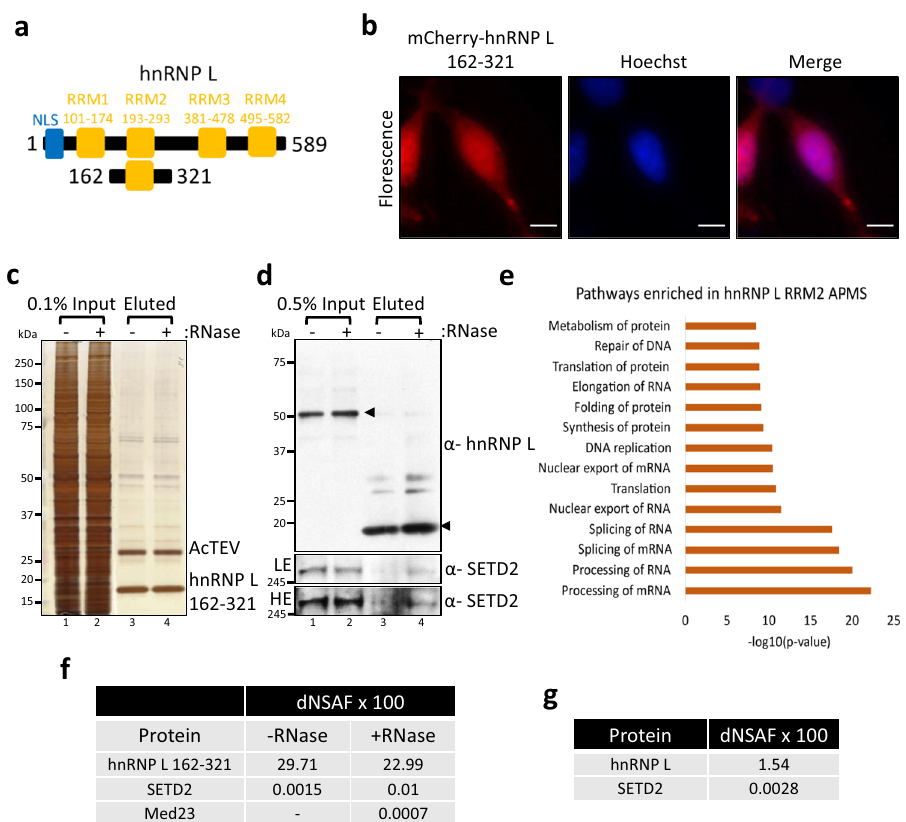
Fig. 1 Puri fi cation of hnRNP L RRM2 reveals SETD2 as an interactor. a Cartoon illustrating the truncation of hnRNP L along with the known domains. RRM RNA-recognition motif, NLS nuclear localization signal. b Microscopy images showing localization of mCherry-hnRNP L 162 – 321. The scale bar is 10 µ m. The experiment was repeated at least four times all yielding similar results. c , d Halo puri fi cation was performed from extracts of 293T cells expressing Halo-hnRNP L 162 – 321. Input and eluted samples were resolved on gel followed by silver staining or western blotting. The expected band for the target proteins are depicted by arrows. HE high exposure, LE low exposure. The experiment was repeated at least two times all yielding similar results. e IPA (Ingenuity Pathway Analysis) of proteins enriched in Halo-hnRNP L 162 – 321 puri fi cation. f , g Table showing the dNSAFs ×100 of the listed protein. dNSAF distributed normalized spectral abundance